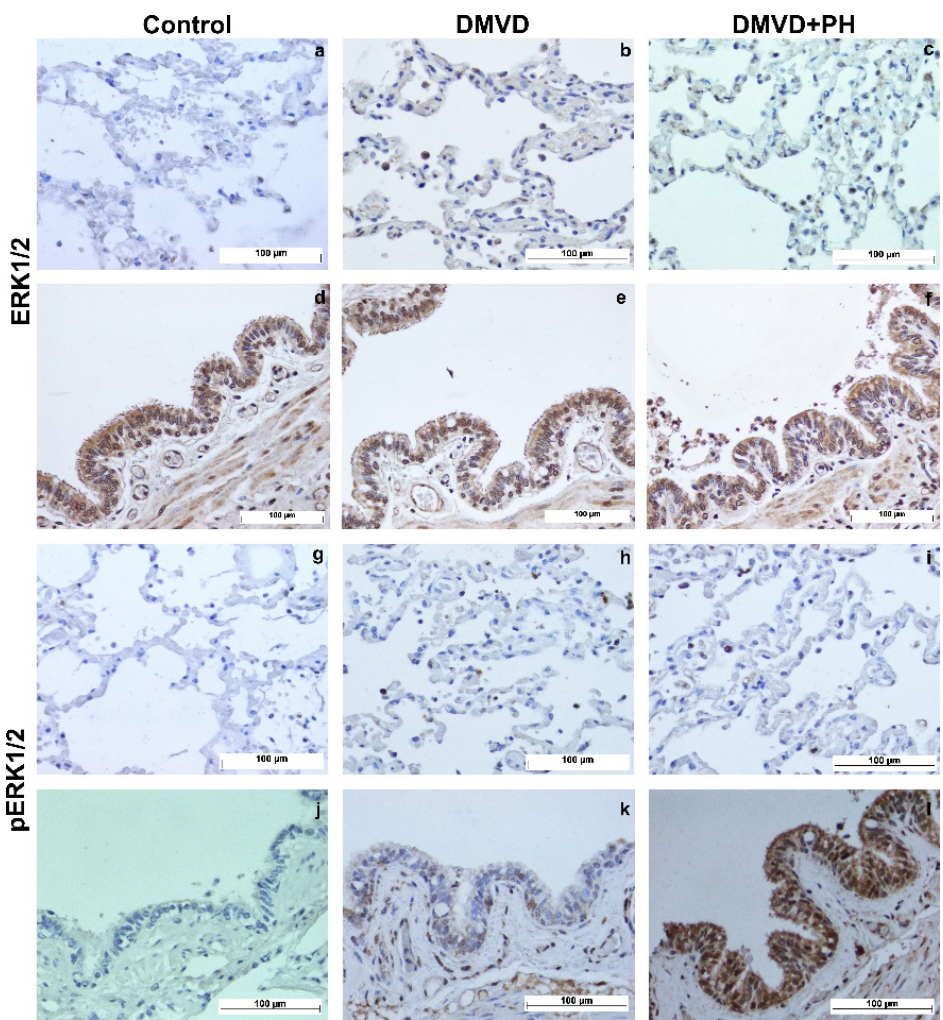
Figure 4. The expression of ERK1/2 and pERK1/2 in pneumocytes, PAMs (top row) and bronchial epithelial cells (bottom row) of dogs in the control ( a , d , g , j ), degenerative mitral valve disease (DMVD) ( b , e , h , k ) and degenerative mitral valve disease with pulmonary hypertension (DMVD with PH) groups ( c , f , i , l ) presented as brown color (Labeled streptavidin-biotin, Immunohistochem- istry, Mayer’s Hematoxylin counterstained, 400× magnification).